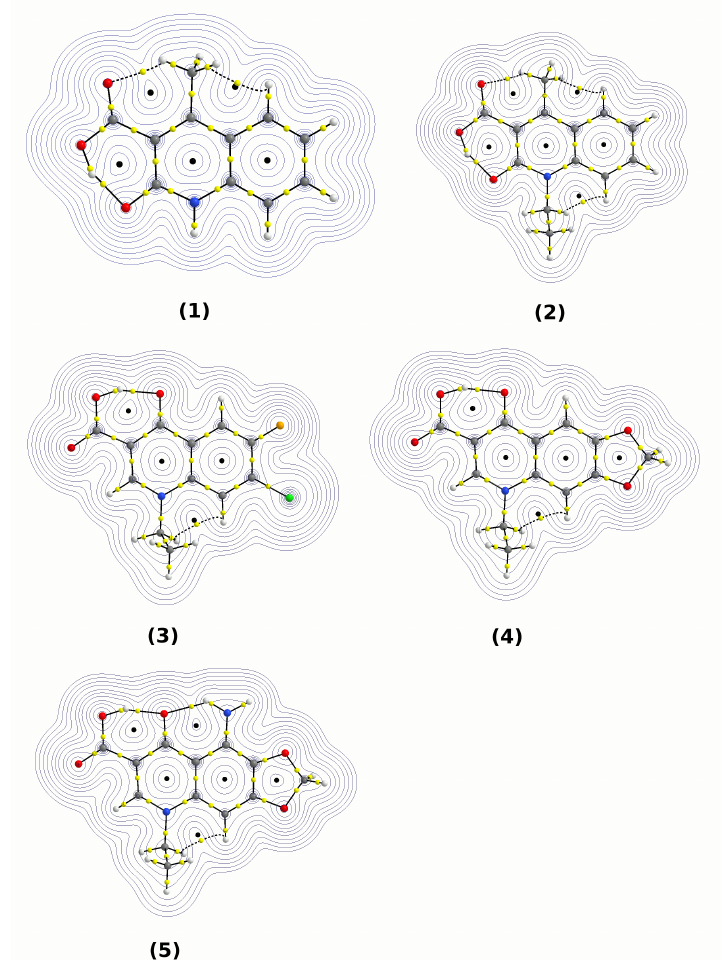
Figure 2. Topological maps of electron density based on AIM theory. Small yellow spheres denote bond critical points (BCPs), small black spheres denote ring critical points (RCPs). Atom colour coding: oxygen atoms, red; hydrogen atoms, white; carbon atoms, grey; chlorine atom, green; fluorine atom, orange; and nitrogen atoms,